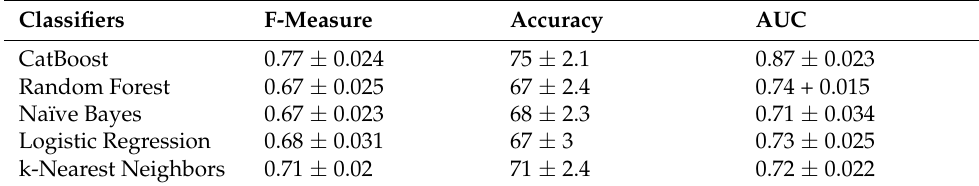
Table 2. Performance scores of various